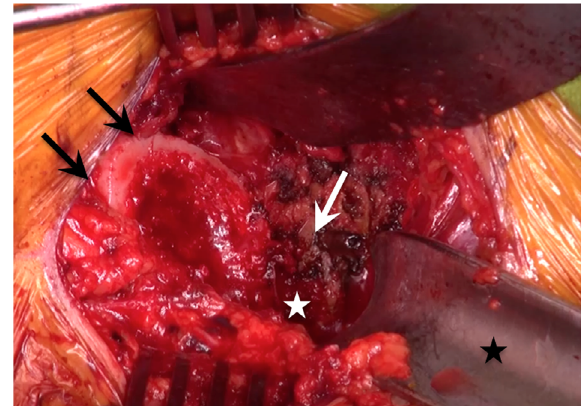
Figure 6. After the femoral osteotomy, it is important to perform a femoral release, with a posterior (white arrow) and lateral capsulotomy (white star) around the greater trochanter (the black arrows show the